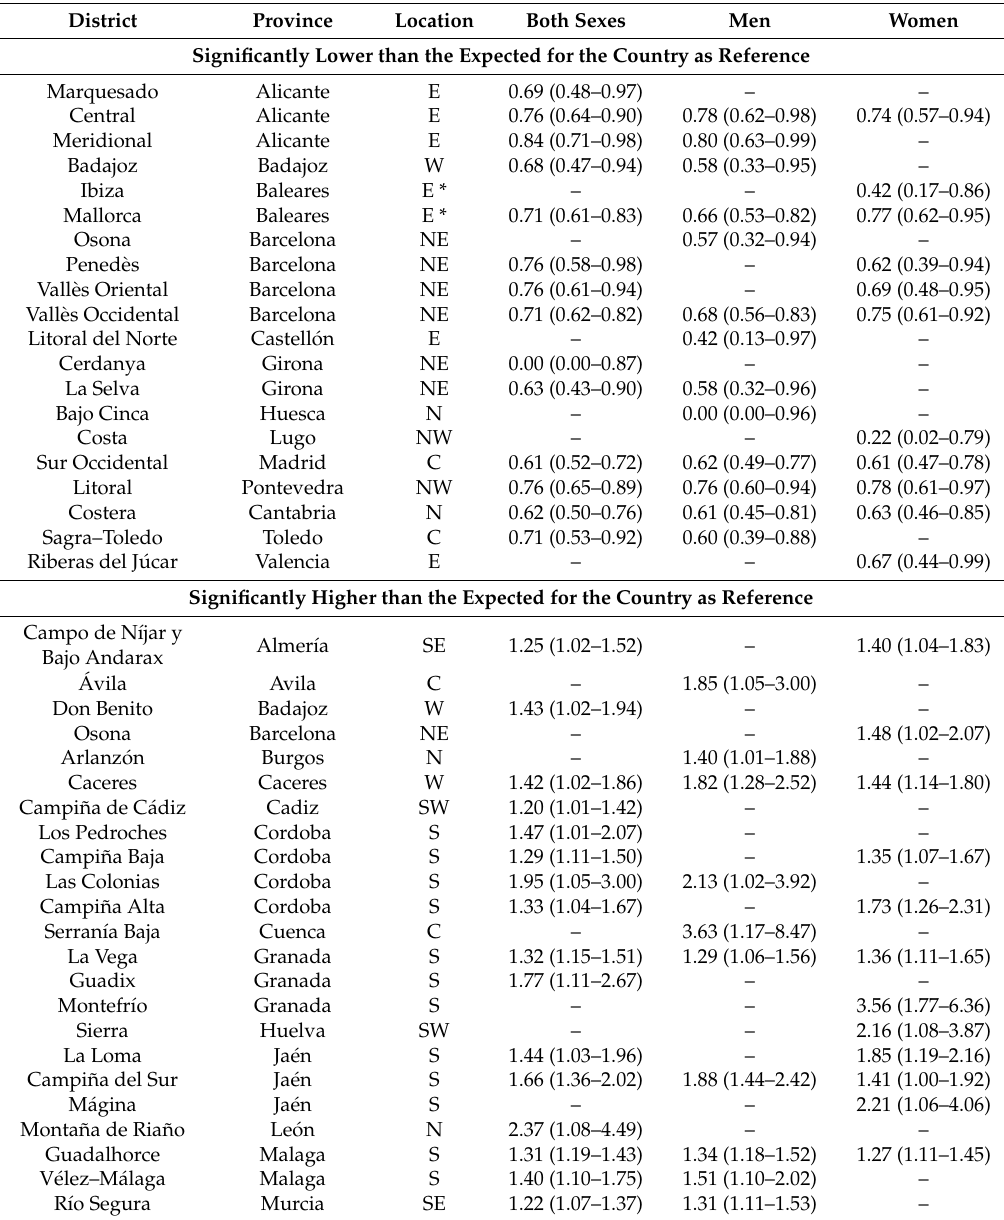
Table 3. Standardised mortality ratio 1999–2013 (95% CI) for rare congenital anomalies, by sex. Only districts with statistically significant values are